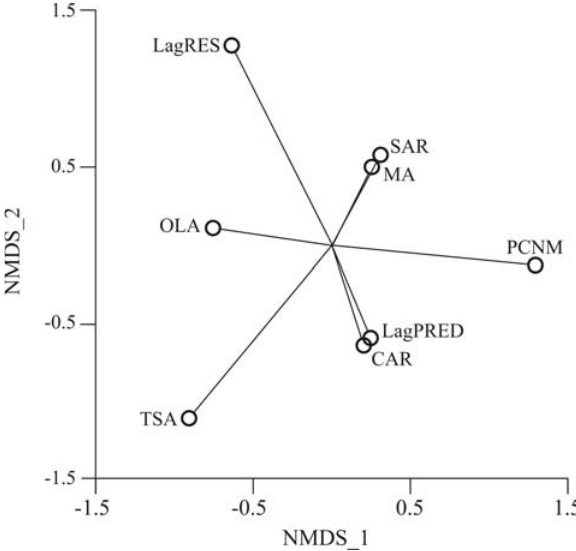
Figure 2 - Distribution of spatial regression methods in the 2D solution of non-metricmultidimensionalscaling(NMDS)basedontheirstandardized slopes. The methods were: Ordinary Least-Squares (OLS); Principal Co- ordinate of Neighbor Matrices (PCNM); Lagged Response (LagRES); LaggedPredictor(LagPRED);SimultaneousAutoregression(SAR);Con- ditional Autoregression (CAR); Moving Average (MA); Trend Surface Analysis